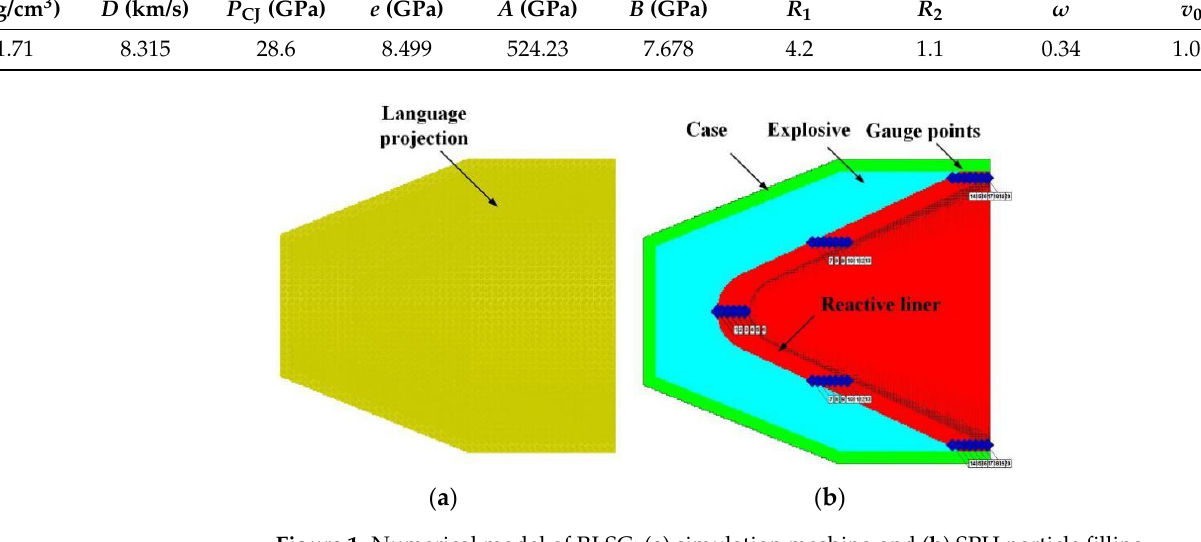
Figure 1. Numerical model of RLSC: ( a ) simulation meshing and ( b ) SPH particle filling.